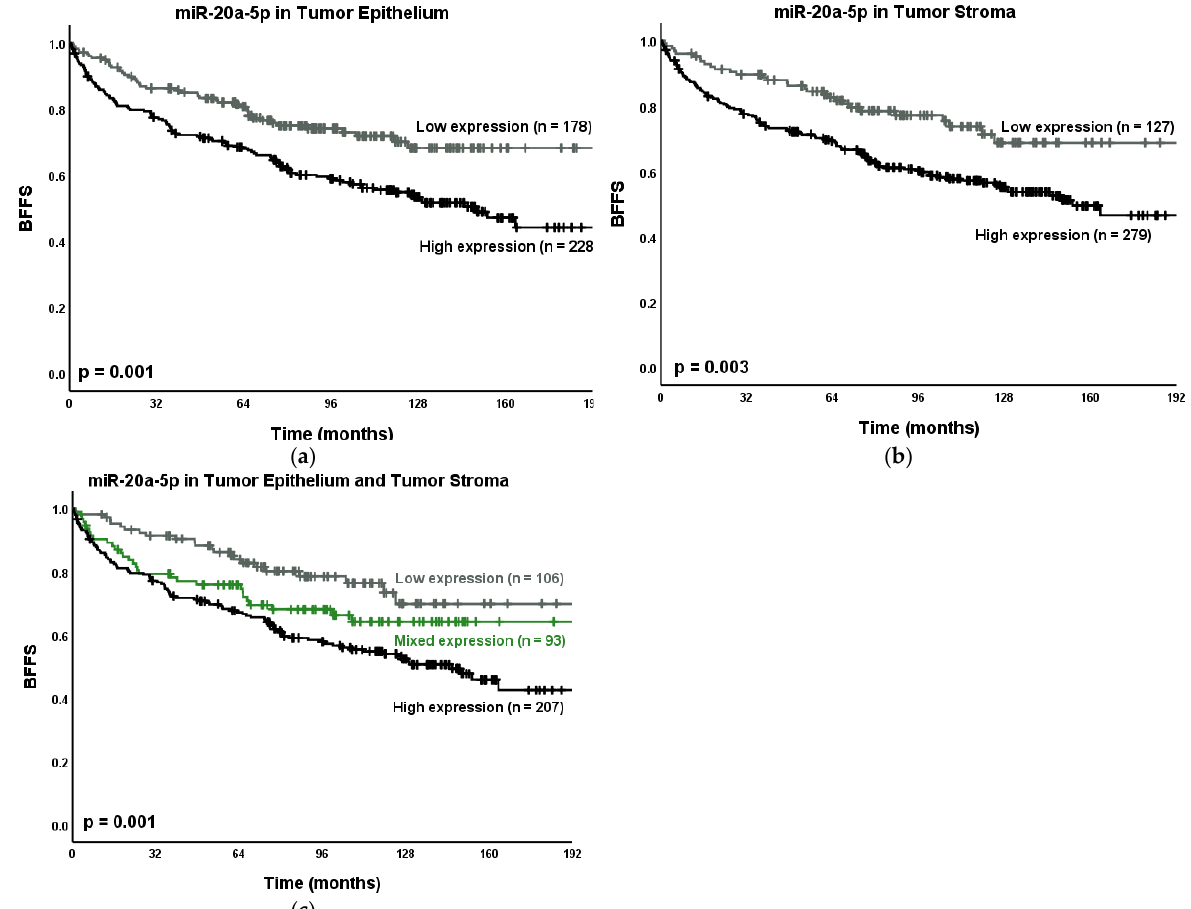
Figure 5. Kaplan – Meier curves presenting the relations between the PCa outcome BF and miR-20a-5p expression in ( a ) TE; ( b ) TS and ( c ) TE + TS. Abbreviations: BFFS = Biochemical failure-free survival; CFFS = clinical failure-free survival; n = number; p = p -value. Table 1. miR-20a-5p expression as predictor for biochemical failure (BF), clinical failure (CF) and prostate cancer death (PCD) in prostate cancer (PCa) patients. Univariate analysis; log rank. Significant p -values marked in bold. Abbreviations: n = number; p = p -value; TS = tumor stroma; TE = tumor